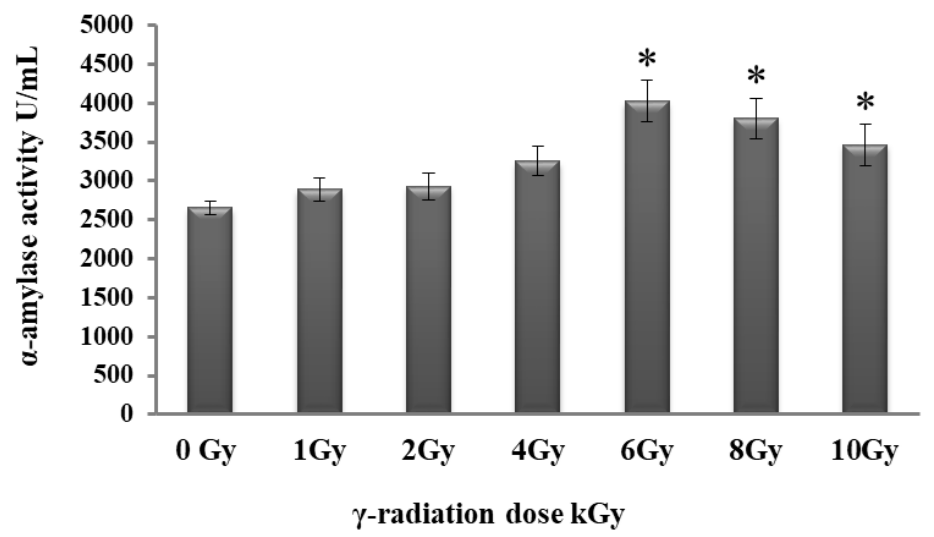
Figure 3. Effects of gamma irradiation on the production of alpha-amylase enzyme by MS009; * p ≤ 0.05 Table 6. Alpha-amylase-specific activity using different purification methods.